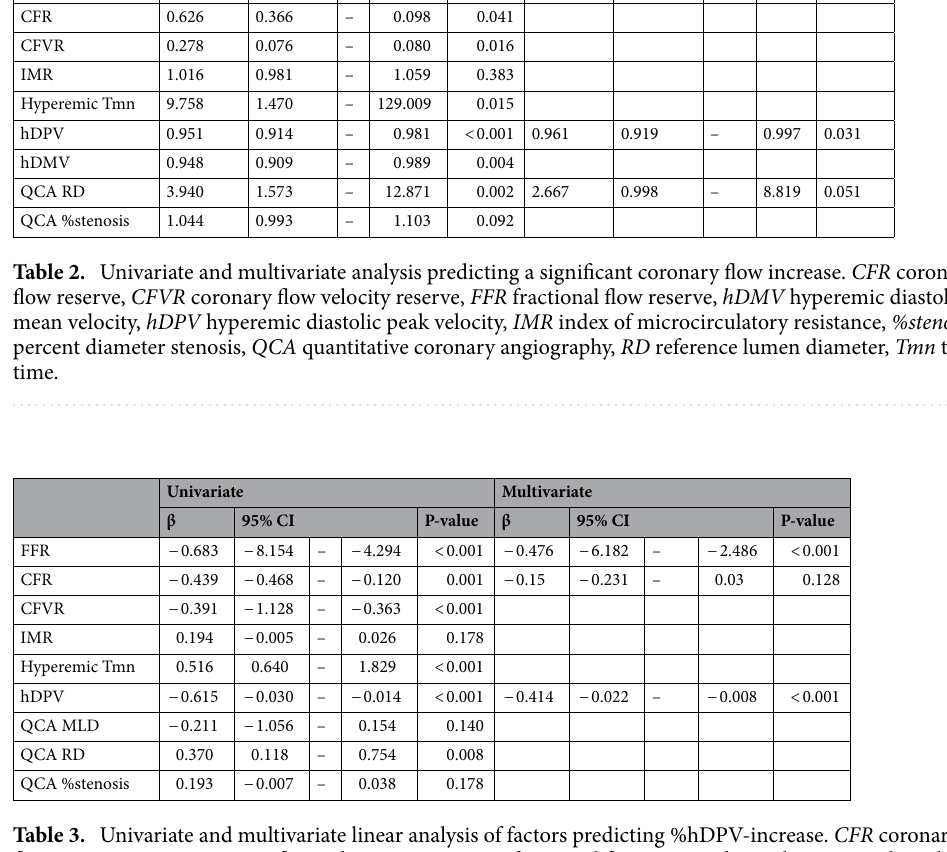
Table 3. Univariate and multivariate linear analysis of factors predicting %hDPV-increase. CFR coronary flow reserve, CFVR coronary flow velocity reserve, FFR fractional flow reserve, hDPV hyperemic diastolic peak velocity, IMR index of microcirculatory resistance, MLD minimum lumen diameter, %stenosis percent diameter stenosis, QCA quantitative coronary angiography, RD reference lumen diameter, Tmn transit